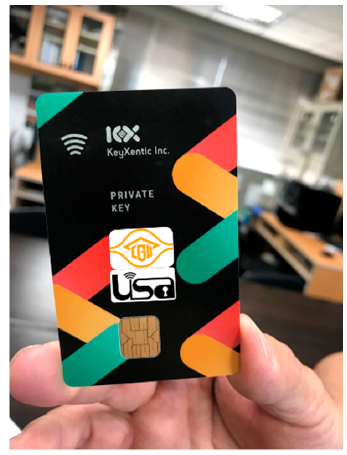
Figure 13. Smartcard.